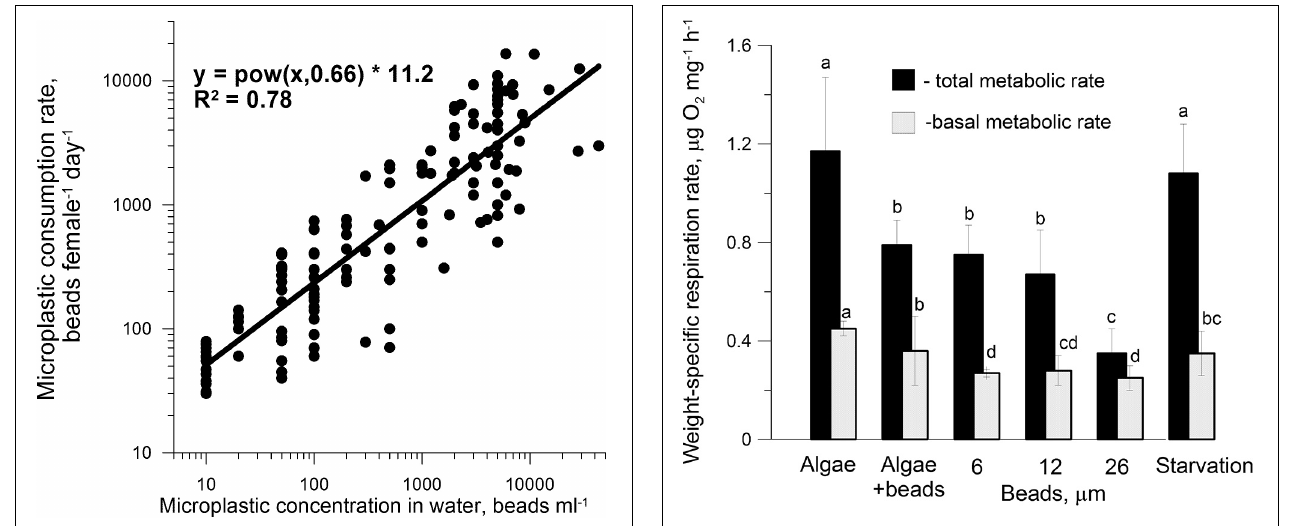
FIGURE 5 | Consumption rates of 6 µ m diameter microplastics (estimated by numbers of beads in fecal pellets inspected hourly) in C. helgolandicus females exposed for 7 h to water containing Rhodomonas salina ( ∼ 5,000 cells ml − 1 ) and different amounts of microplastic beads (10–44,000 beads ml − 1 ). n = 154) in microplastic consumption rates from 50.8 ± 17.3